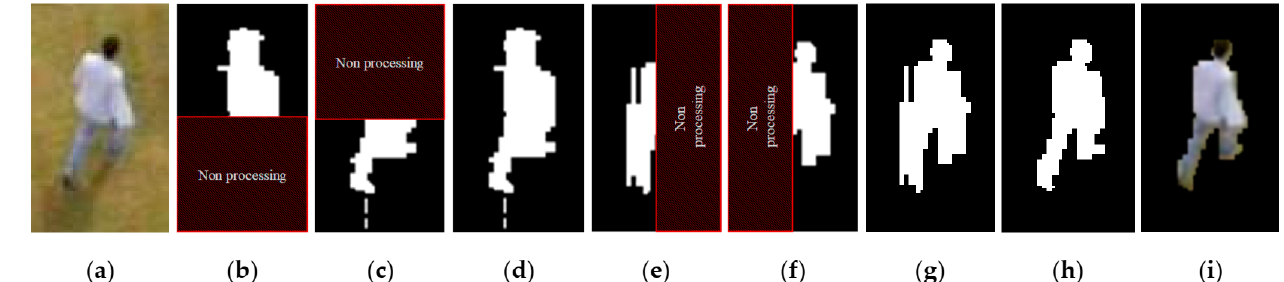
Figure 8. Mask scanning results. ( a ) Original image; ( b , c ) upper and lower segmentation, respectively; ( d ) vertical mask scanning; ( e , f ) left and right segmentation, respectively; ( g ) horizontal mask scan; ( h ) finalized mask; ( i ) identified image.